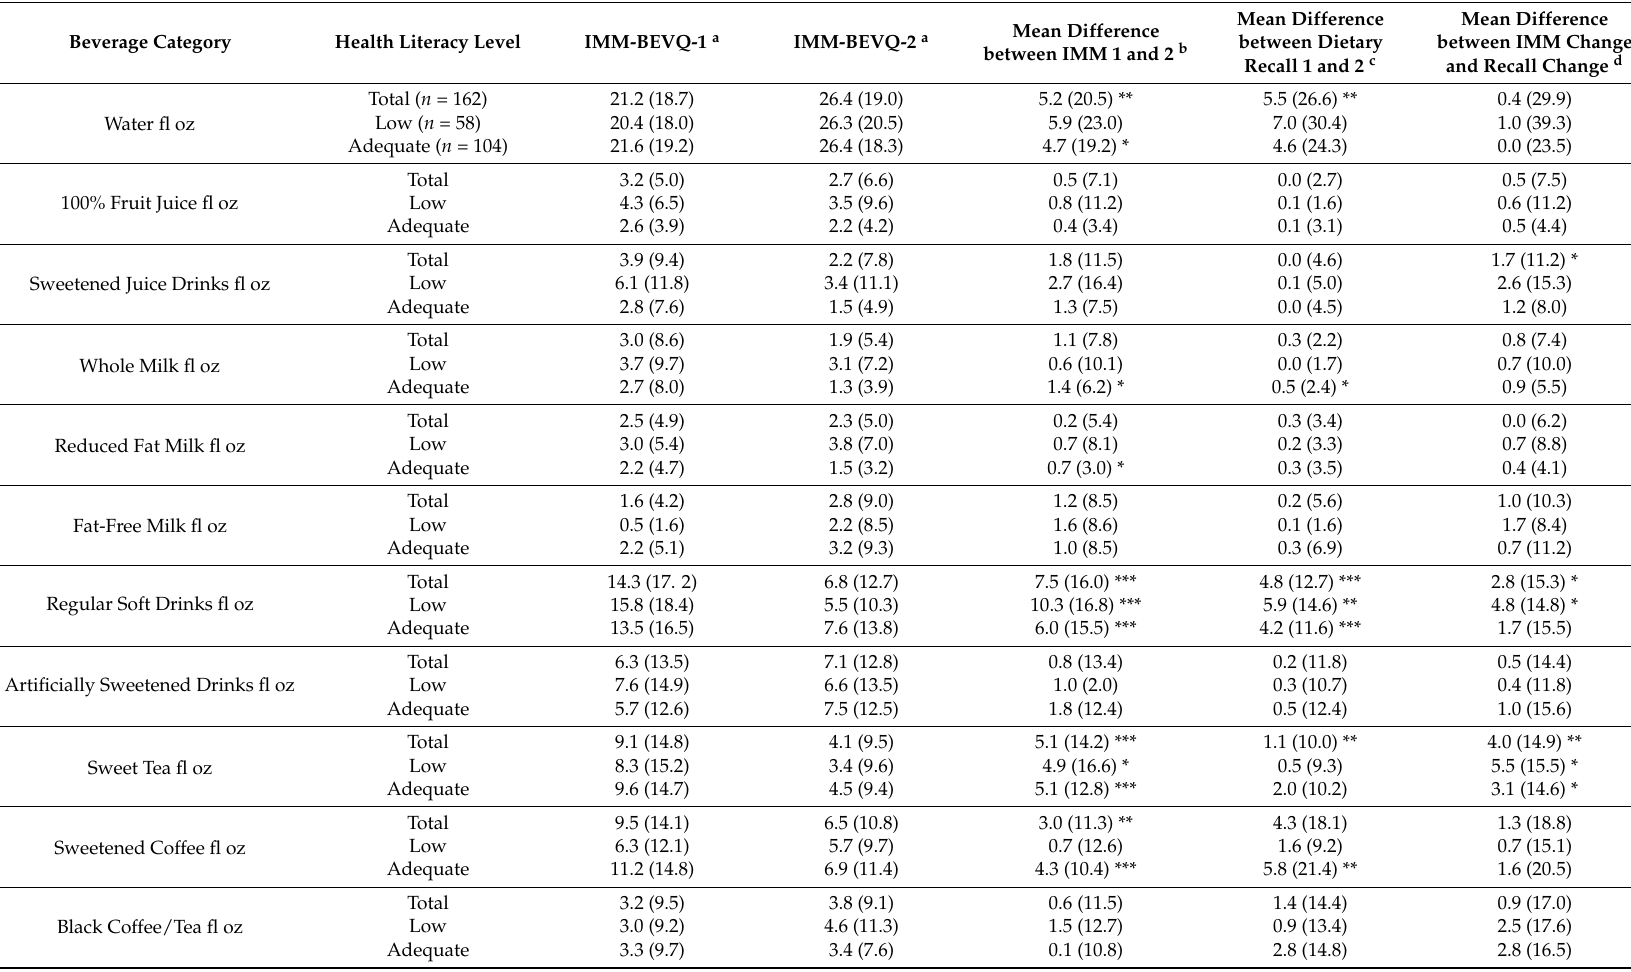
Table 3. Sensitivity to change of an interactive multimedia beverage intake questionnaire (IMM-BEVQ) over a six-month intervention targeting either beverage consumption or physical